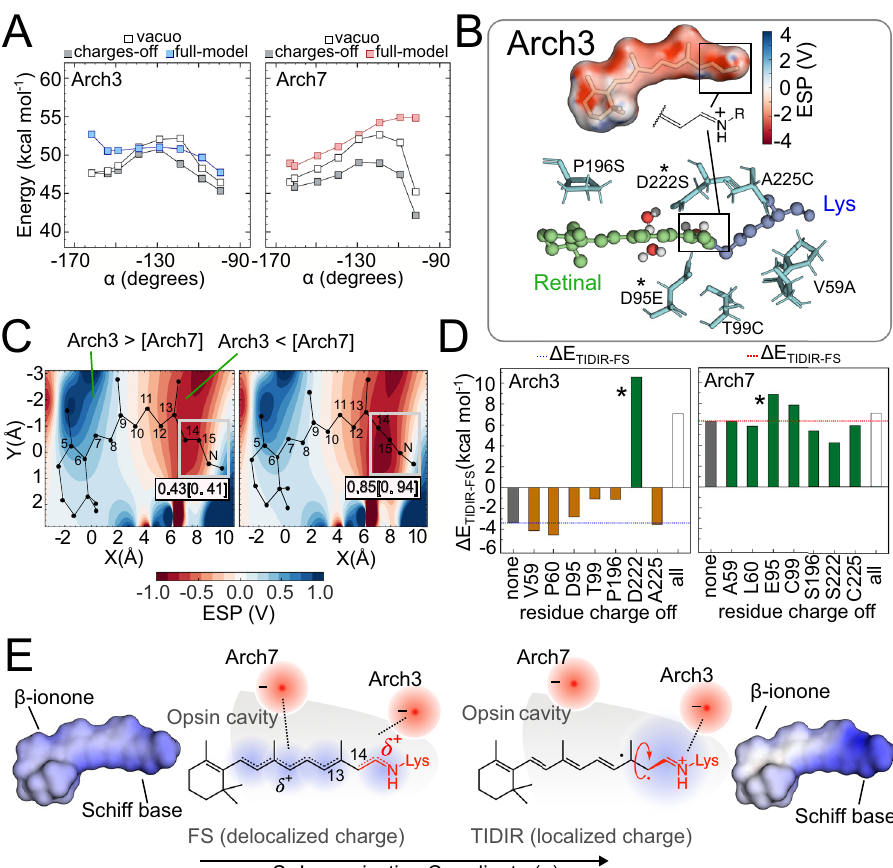
Fig. 4 | OriginoftheS 1 isomerizationbarrierinArch3and Arch7.A Effectof the opsinchargesontheisomerizationenergypro fi leforArch3(left)andArch7(right). B Top. Arch3 opsin electrostatic potential projected on the chromophore solvent accessible surface. Bottom. The cavity amino acids distinguishing Arch3 from Arch7. The * symbol indicates the Arch3 (D222) and Arch7 (E95) chromophore counterions. C Two-dimensional plots showing the Arch3-Arch7 electrostatic potential difference at FS (left) and TIDIR (right). The total charge of the framed Schiff-base moiety is also given. D Variation in the Arch3 (left) and Arch7 (right) isomerizationenergyvalueafterzeroingtheresiduechargeofthecavityresiduesin panel B bottom. Reference values are shown as gray bars. Negative and positive isomerization energies are shown in orange and green, respectively. Finally, the